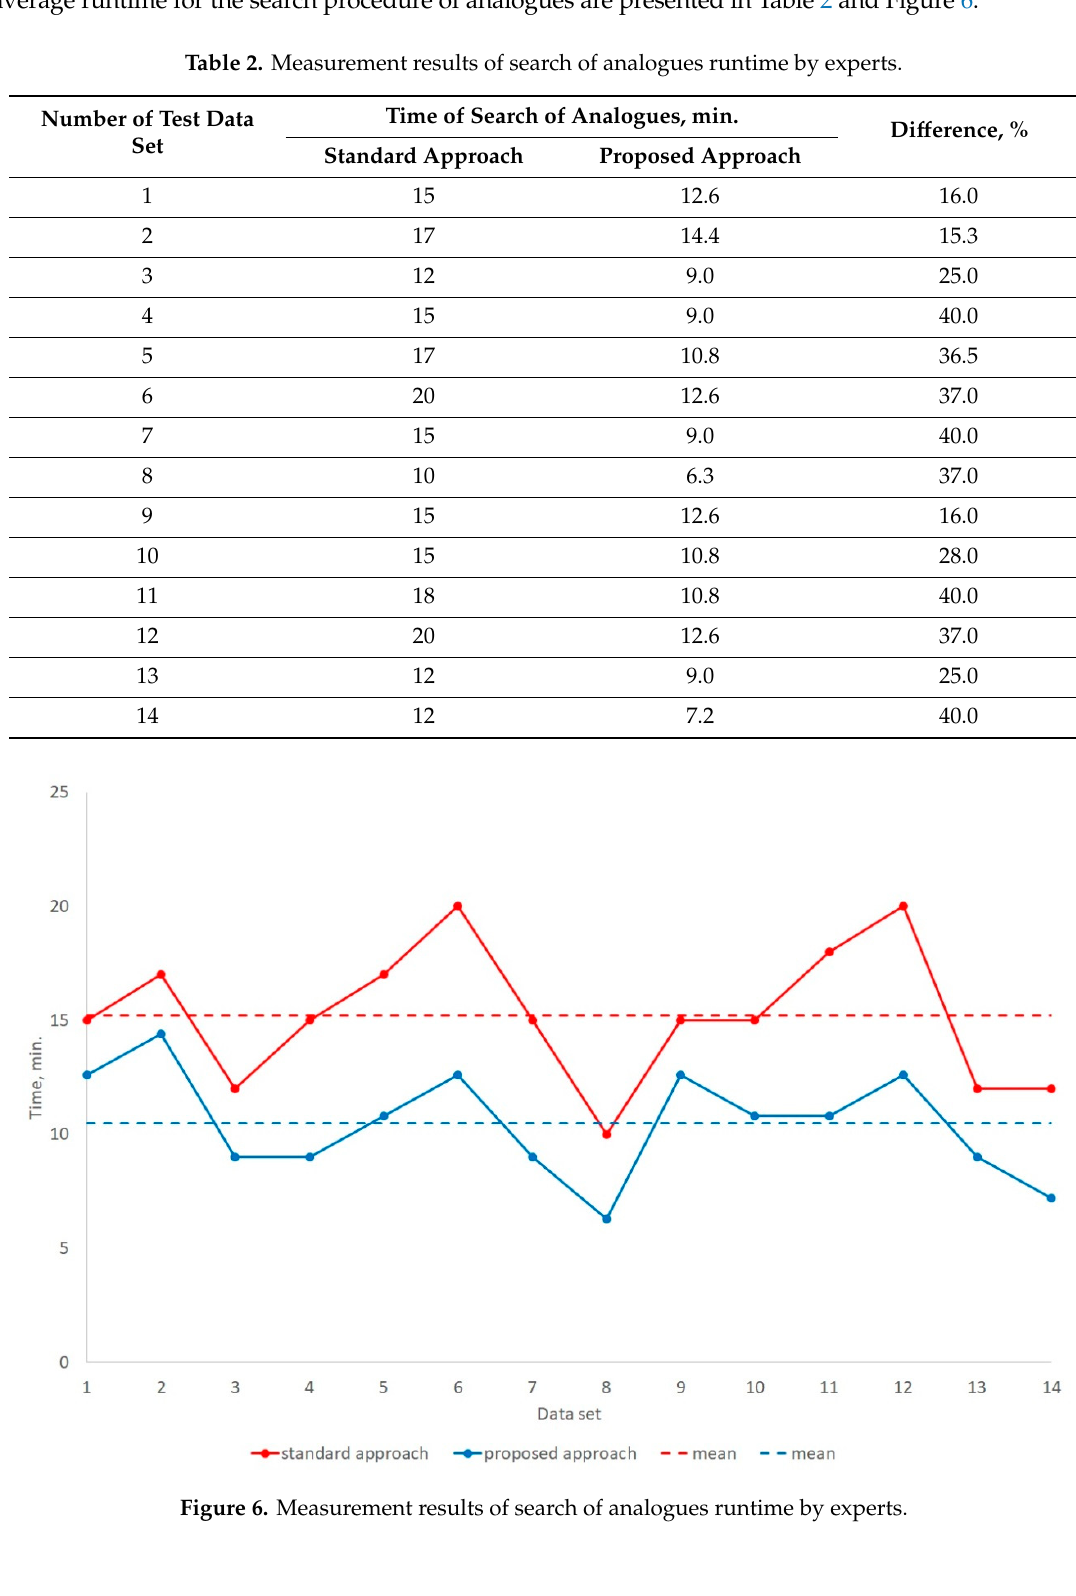
Table 2. Measurement results of search of analogues runtime by experts.